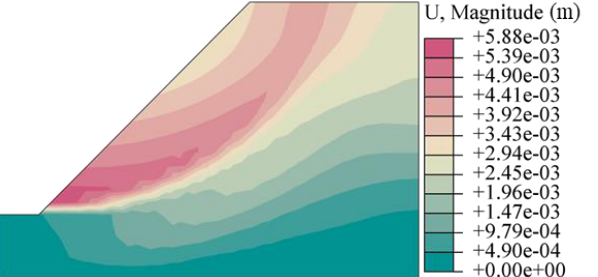
Figure 3. Equivalent displacement cloud calculated by the traditional finite element reduction method.